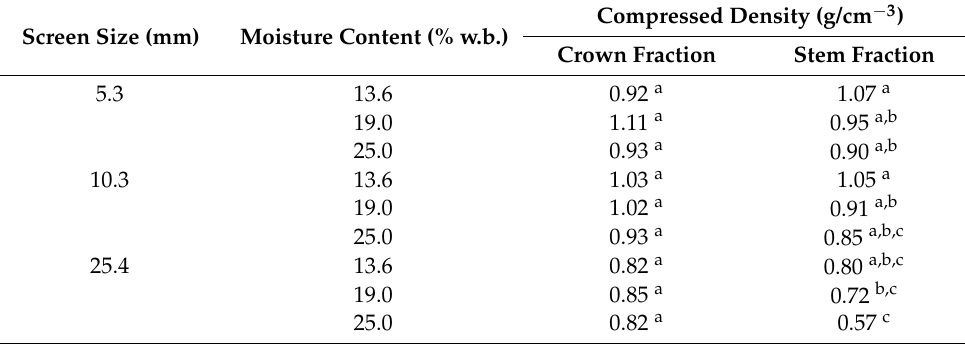
Table 2. Mean values of compressed density of briquettes from poplar tree fractions. Screen Size (mm) Moisture Content (%